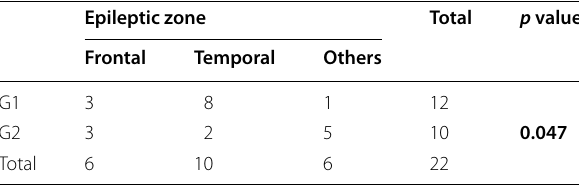
Table 1 Comparison of the epileptic region of G1 and G2